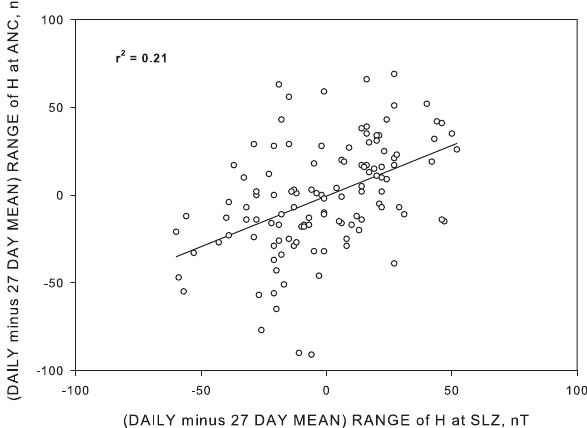
Fig. 3b. Mass plot of the daily range of H at ANC after removing the 27-day running mean plotted against the values at SLZ.